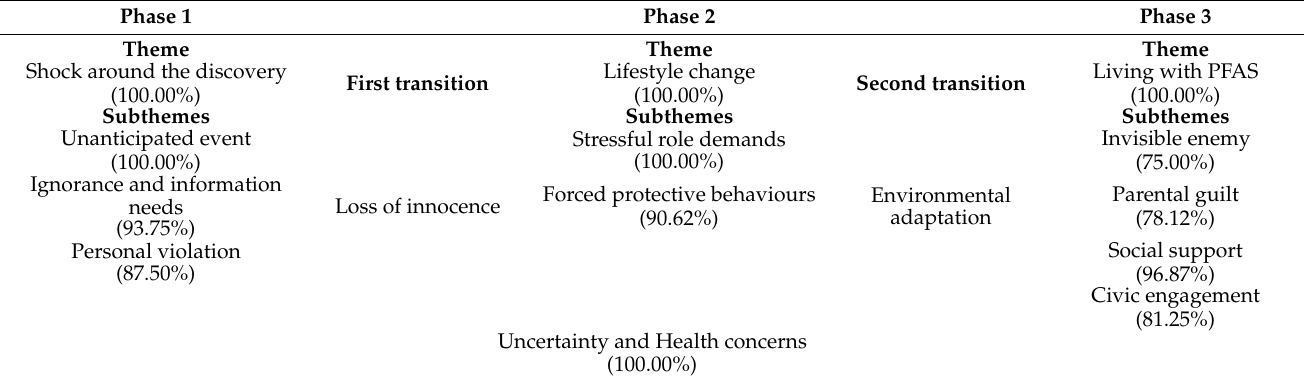
Table 3. The Process of Psychological Impact of the PFAS Contamination in